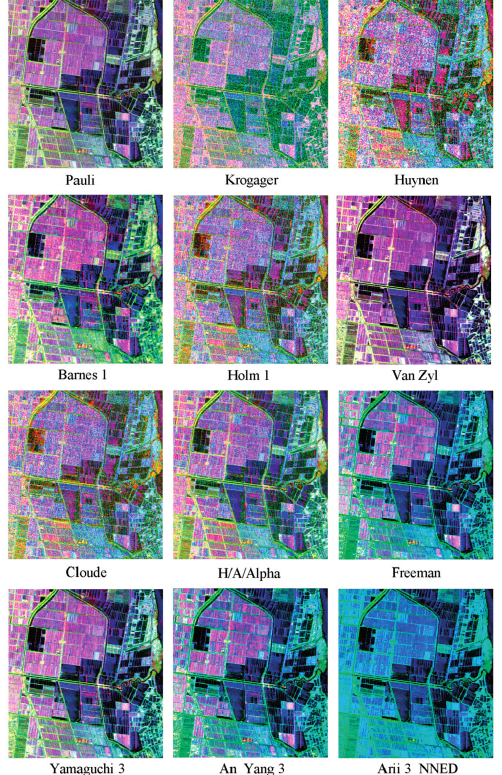
Figure 3. RGB composition images of different polarimetric